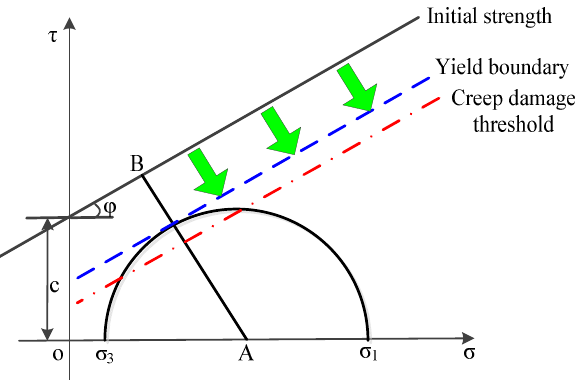
Figure 4. Schematic diagram of block strength attenuation.